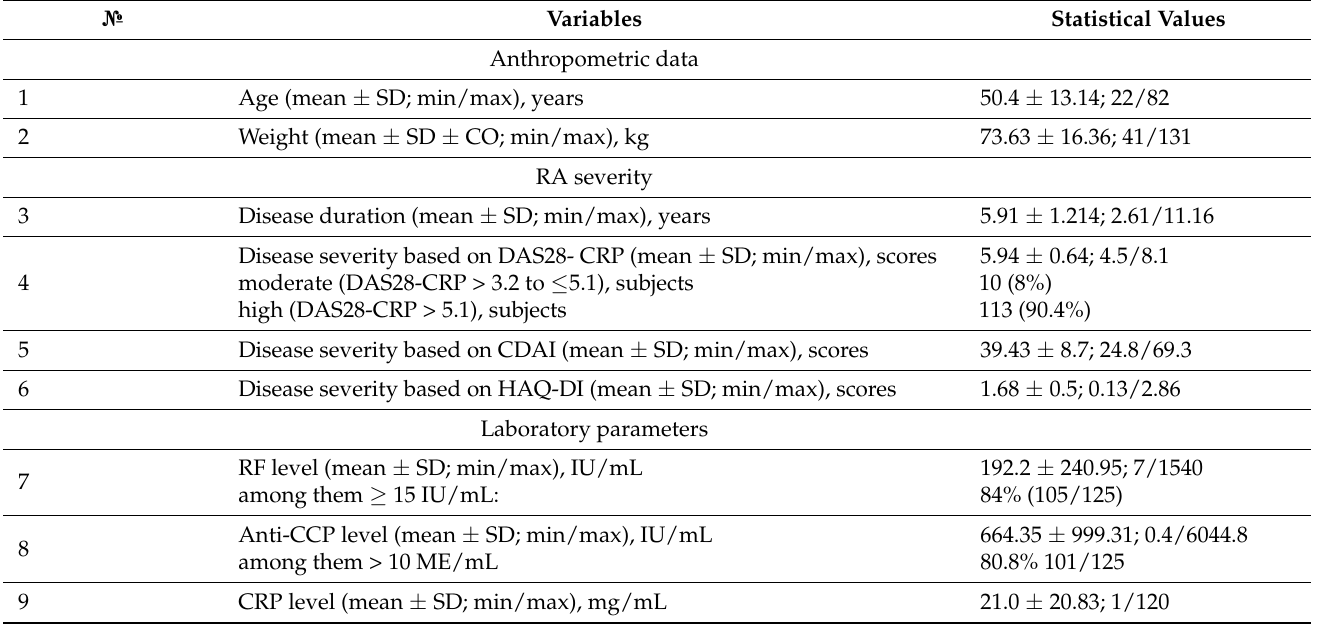
Table 4. Clinical and laboratory characteristics of the 125 RA